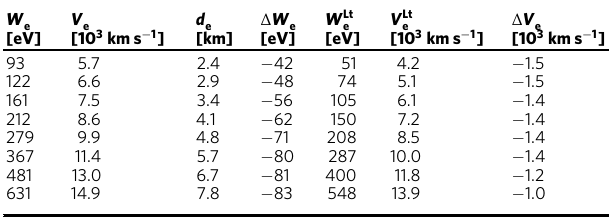
W V d e and e denote the electron energy and kinetic velocity, respectively. e is the gyro-diameter All of the data plots in this study are generated with the IRFU-Matlab software applied to (see Fig. 5b). Δ W e and Δ V e represent the changes of the electron energy and velocity across the publicly available MMS database. The IRFU-Matlab software is available by the gyro-diameter (see Fig. 5d), while the superscript Lt denotes the Liouville tracing values downloading from https://github.com/irfu/irfu-matlab. plane, while unit vectors are projected when they are within ±22 : 5 (cid:5) respect to the plane. Liouville mapping of the electron crescents . The crescents generating the large- amplitude electron Bernstein waves gyrate from the magnetosheath ( + N ) side of the neutral line. We get the mapped electron phase-space density by using the Liouville ’ s theorem 47 that the electron phase-space density are conserved along the particle trajectories throughout the gyro-motion at the electron-scale boundary (see Fig. 5). We assume one-dimensional variation of the magnetic fi eld B and the electric fi eld E around the EBWs observations. Here, B is dominated by B M . The electric potential of the electron increases when tracing towards the high-density region 55 (see Fig. 5a, b, d). The electron trajectories (see Fig. 5b) in the plane perpendicular to B are obtained by solving the electron motion equation based on observed electric and magnetic fi elds. Table 1 shows the details of the electron distribution function tracing in velocity space, while the curves in Fig. 5e – i also consider the energy resolution and errors of the phase-space densities. Electron model distribution function for dispersion relation . We use a gyro- tropic ring-type distribution function to model the observed crescents, while the rest of the observed electron populations is modeled by one drifting (along the fi eld line) Maxwellian and two nondrifting Maxwellian cores. The background magnetic fi eld is 30nT, and the electron total number density is 14.1cm (cid:1) 3 . The gyrotropic ring is from superposition of multiple ring-type distribution functions 49 :